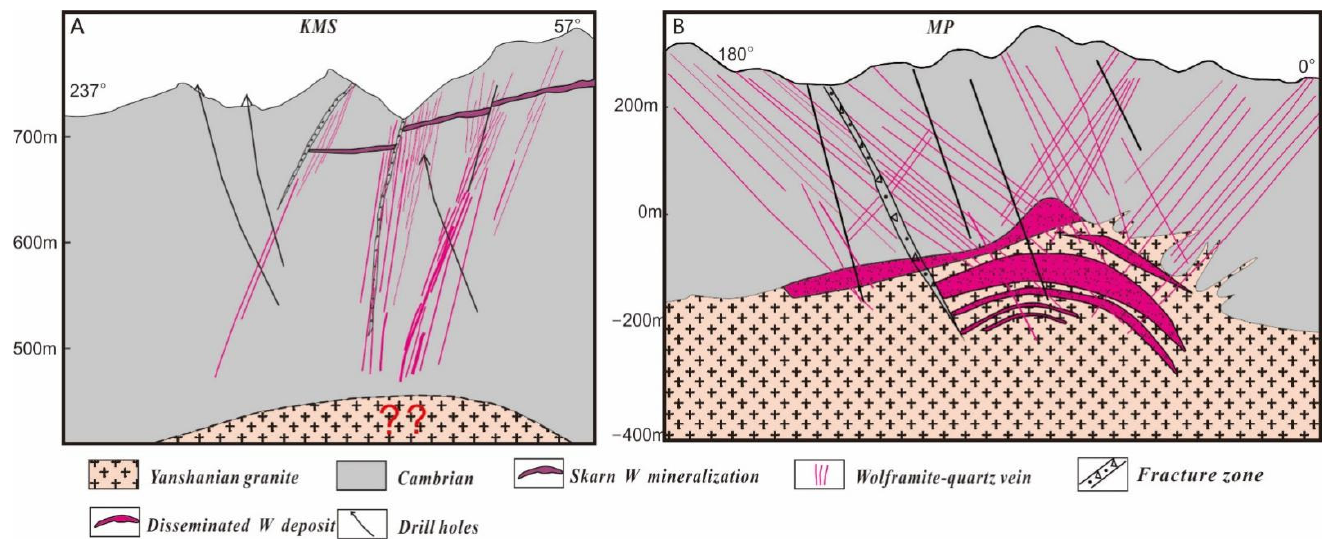
Figure 8. ( A ) Cross section of the Kuimeishan tungsten deposit, the occurrence of the granite underneath is inferred from limited drill cores. ( B ) Cross section of the Maoping quartz vein system, greisen (cupola) and Maoping granite (modified after [23]).